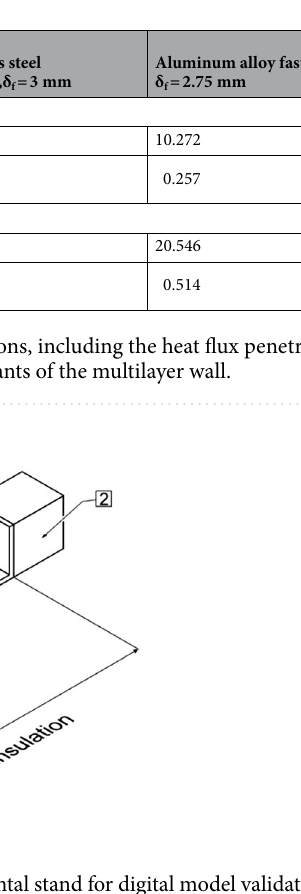
Figure 12. Schematic diagram of the experimental stand for digital model validation (not to scale). Description: 1—building fastener, 2—heater, 3—thermal imaging camera, 4—aluminum plate that simulates multilayer wall external cladding. Dimensions of the air gap and insulation are given in Fig. 9.